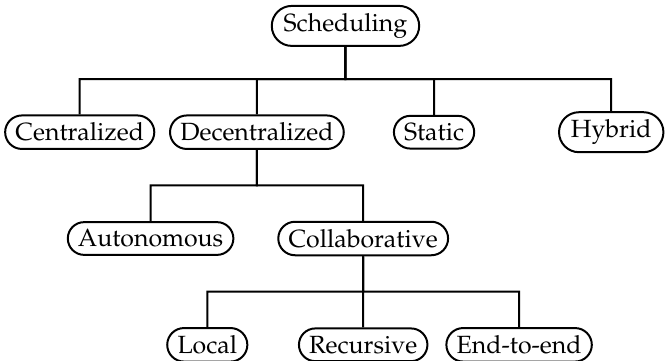
Figure 5. Classification of scheduling strategies according to schedule